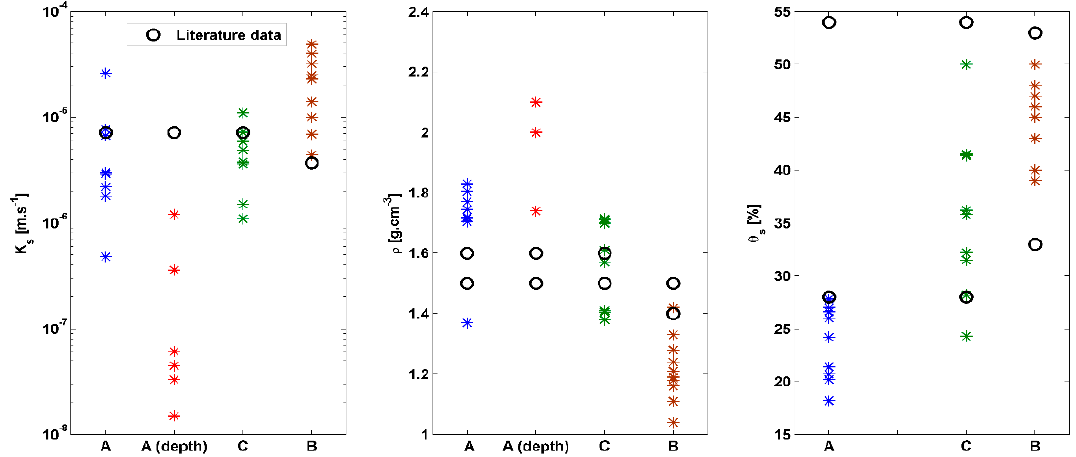
Figure 2. Scatter plot of saturated hydraulic conductivity K s (m · s − 1 ), bulk density ρ (g · cm − 3 ), and saturated water content θ s (%). The K s literature value corresponds to the data mean value, while the two values for (cid:2025) and θ s correspond to ±standard deviation about the mean.